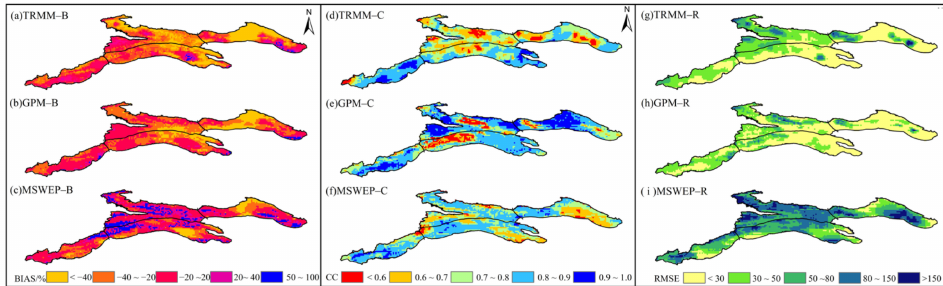
Figure 10. Spatial distribution of BIAS ( a – c ), CC ( d – f ) and RMSE ( g – i ) between precipitation products and measured precipitation interpolation results. TRMM ( a , d , g ); GPM ( b , e , h ); MSWEP ( g – i